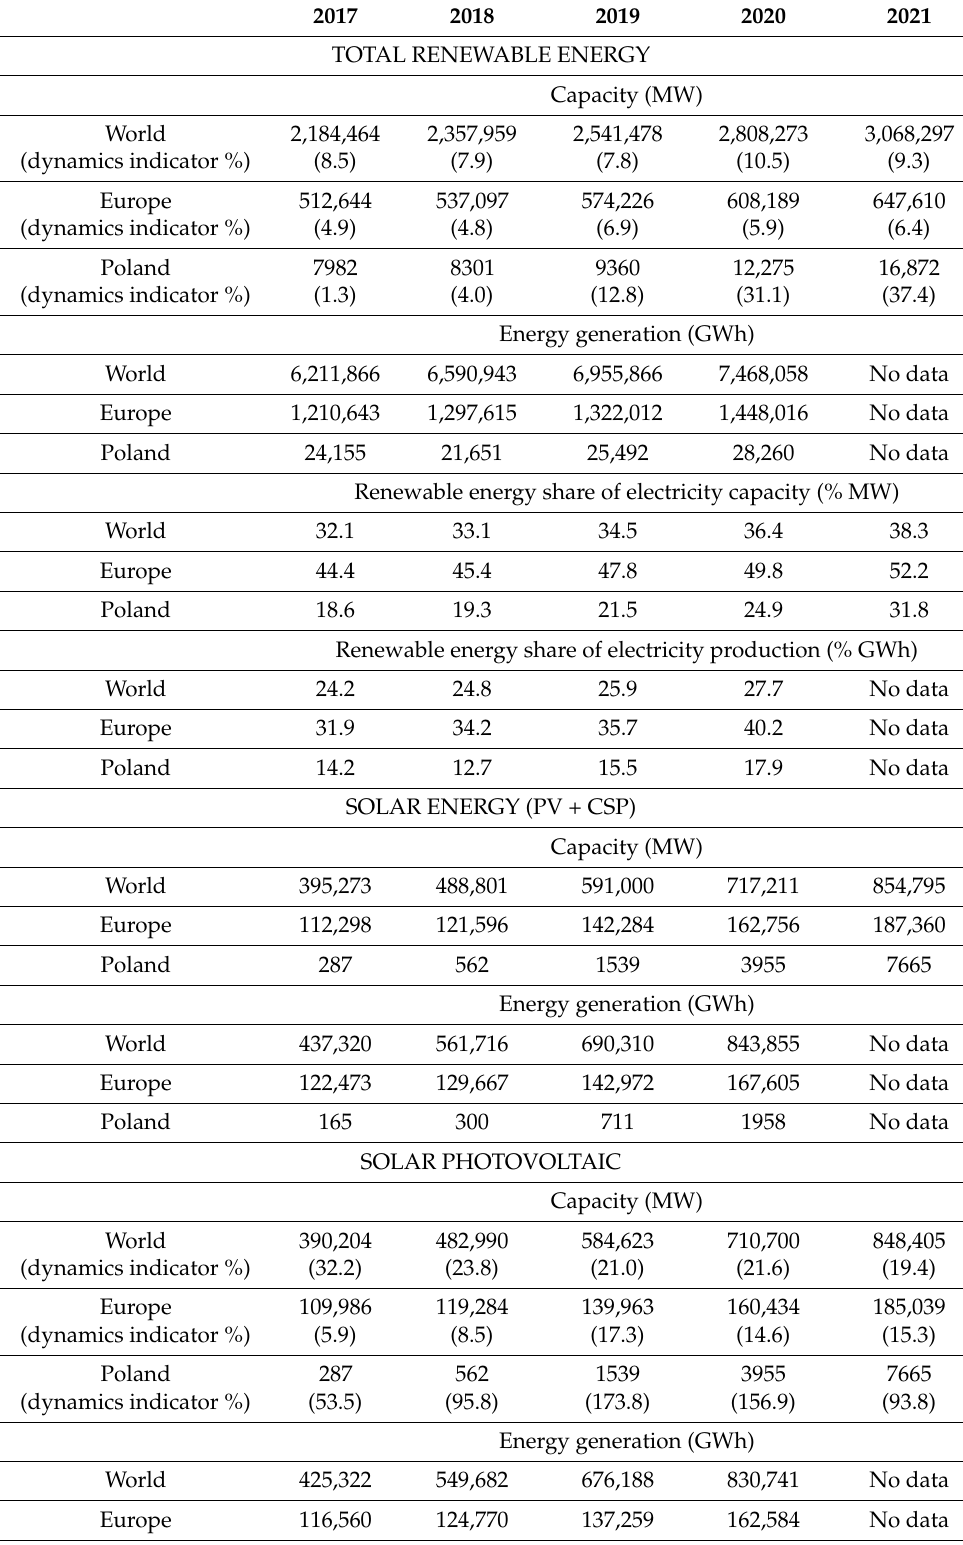
Table 1. Renewable energy sources—a compilation of statistical